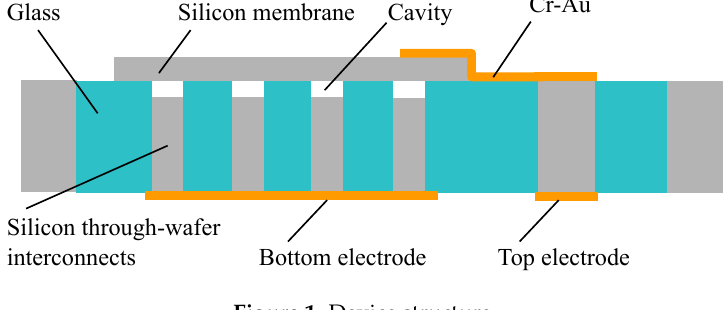
Figure 1. Device structure